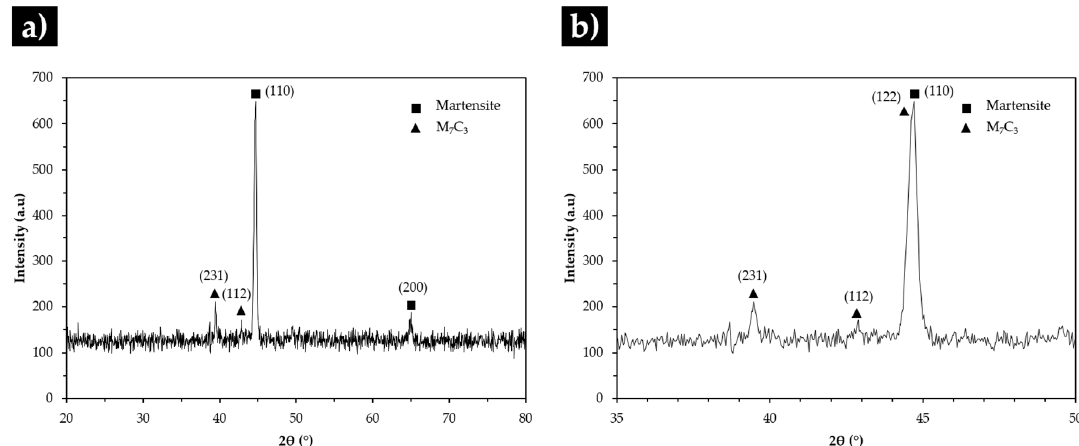
Figure 8. X-ray diffraction (XRD) patterns of the high-Cr WCI in the as-cast condition in the 2 θ range of 20°–80° ( a ) and 35°–50° ( b ).